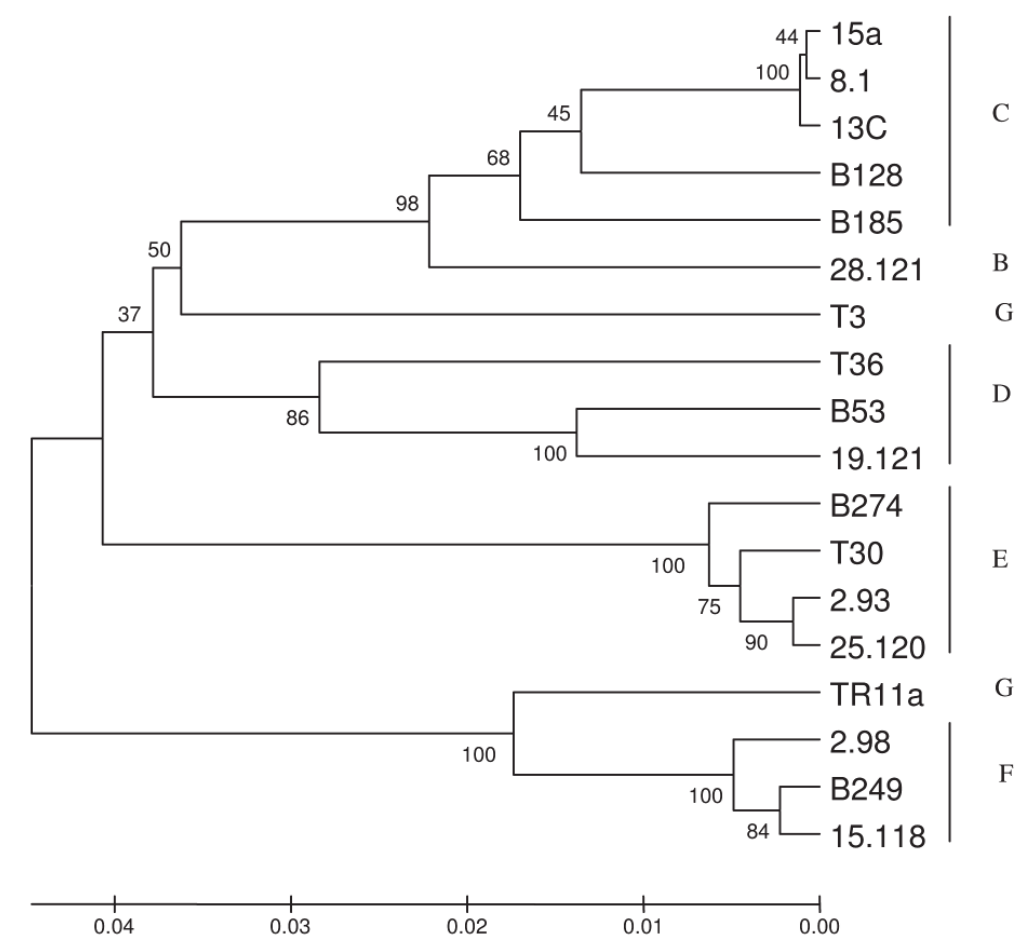
Fig. 3. Dendrogram showing UPGMA clustering of the coat protein (CP) gene sequences of the standards used. CP clones 15a and 8–1 were not analysed by CFLP. Letters on the right refer to the cluster as determined by